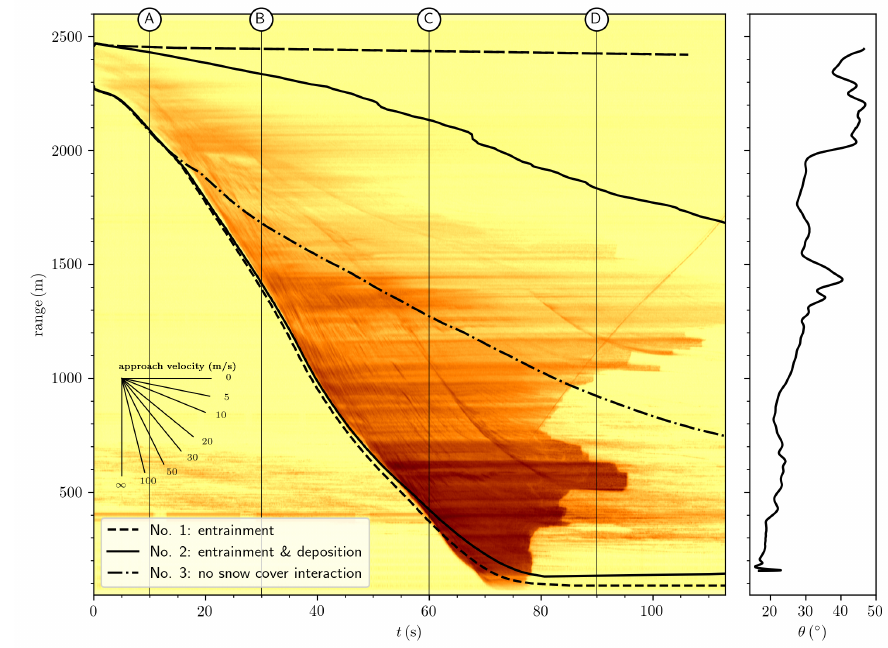
Figure 4. Moving target identification plot of avalanche #0017. The GEODAR data are shown in the background. Black lines give the front and tail position extracted from the simulations. Material and model parameters are optimized to this avalanche. Simulation no. 1 solely includes entrainment, simulation no. 2 includes entrainment and deposition, vertical lines correspond to the snapshots ( A – D ) in Figure 6. Simulation no. 3 is drawn as reference without entrainment and deposition. The slope angle along the line of steepest descend is shown in the right panel. A velocity legend is included for quick translation of front inclination to approach velocity. Black lines represent the front and tail position extracted from simulations (Section